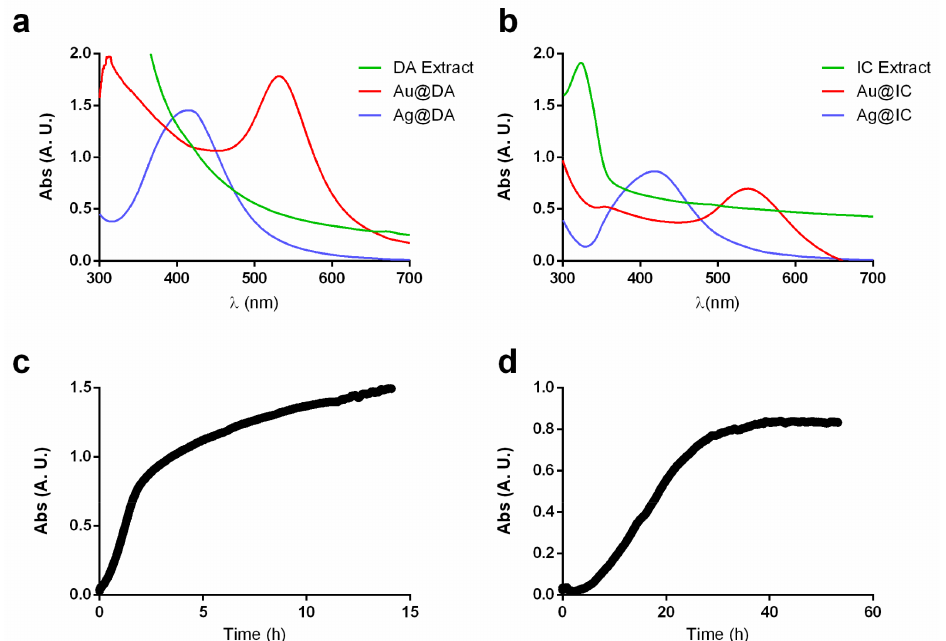
Figure 2. UV-Vis spectra of ( a ) DA extract, Au@DA and Ag@DA and ( b ) Iridaea cordata (IC)